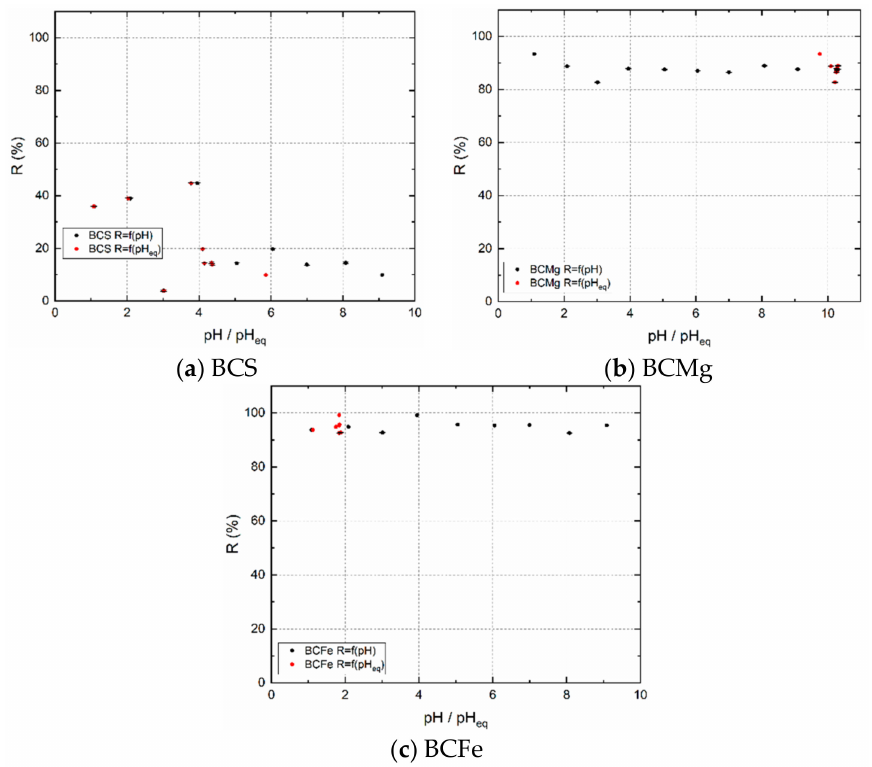
Figure 2. ( a ) BCS, ( b ) BCMg, ( c ) BCFe. The dependence of R on pH and pH eq . Tracer 99m TcO 4 − , m = 0.02 g, V = 2 cm 3 , t = 24